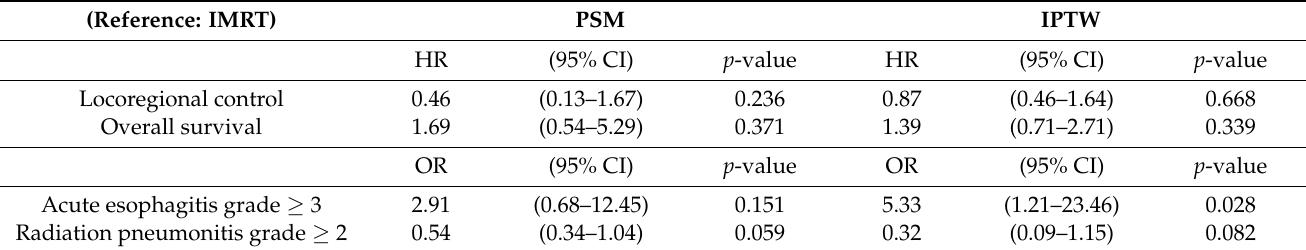
Table 6. Patient, tumor, and treatment characteristics after propensity score matching and